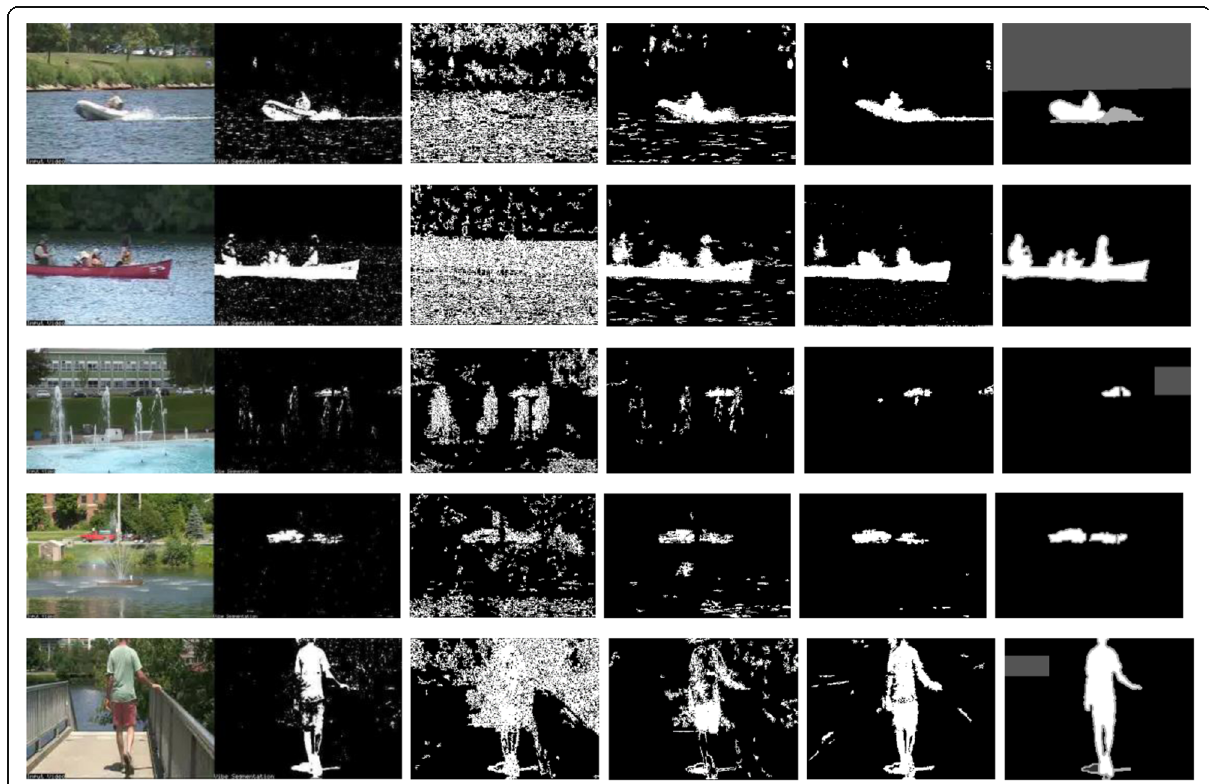
Fig. 12 Background subtraction results on the ChangeDetection.net dataset dynamic background image sequences — original image frames (first column), results obtained by ViBe (second column), results obtained by SILTP (third column), results obtained by MC-SILTP (fourth column), results obtained by our method (fifth column), and ground truths (last